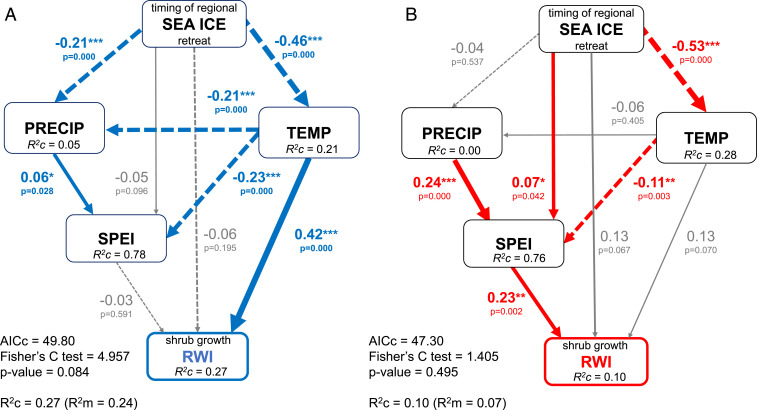
Piecewise SEMs showing the relative importance of the regional sea ice changes and summer climate on mean annual shrub growth for period 1979 to 2008. (A) Increasers (blue arrows; n = 390 mean annual growth records; 13 chronologies) and (B) decreasers (red arrows, n = 270 mean annual growth records; 9 chronologies). Each response variable was fit to a linear mixed effect model with random intercept for a site. Positive and negative causal relationships are denoted with solid and dashed arrows, respectively, with the width of the arrows proportional to the strength of the path coefficients. Gray arrows indicate nonsignificant relationships. Numbers on the arrows are standardized parameter estimates with significance levels denoted using asterisks (i.e., *P < 0.05, **P < 0.01, ***P < 0.001). Conditional (R2c) and marginal (R2m) R2 for response variable for each model are indicated in the Lower Left corners. Variables used in the model: RWI, ring width index, i.e., standardized mean ring width; timing of regional sea ice retreat (LRD, last retreat day of sea ice expressed as day of the year for each sea ice region, z-score; see Materials and Methods); summer (i.e., June to August) standardized precipitation evapotranspiration index (SPEI), precipitation (PRECIP), and temperature (TEMP). Full model statistics with SEs are presented in SI Appendix, Tables S10 and S11.